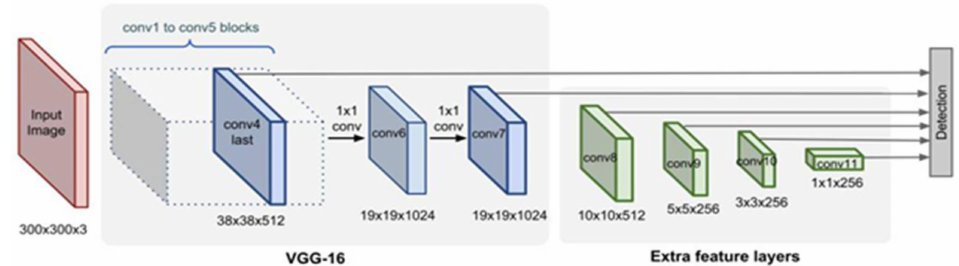
Figure 6. SSD uses feature layers at the end of base network, which predicts the class score with four offset values to default